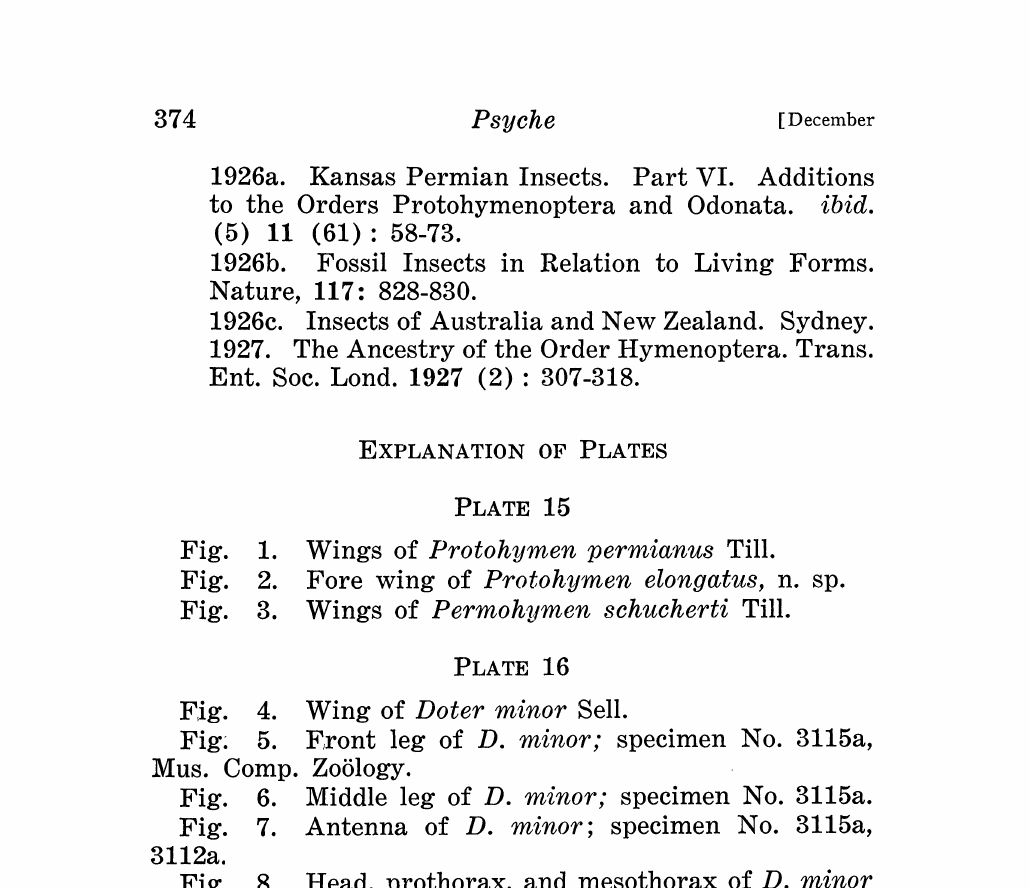
Fig. 1. Wings of Protohymen permianus Till. Fig. 2. Fore wing of Protohymen elongatus, n. sp. o Permohymen schucherti Till. Fig. 3. Wings PLATE 16 F.ig. 4. Wing of Doter minor Sell. Fig: 5. Front leg of D. minor; specimen No. 3115a, Mus. Comp. ZoSlogy. Fig. 6. Middle leg of D. minor; specimen No. 3115a. o D. minor; specimen No. 3115a, Fig. 7. Antenna 3112a. Fig. 8. Head, prothorax, and mesothorax of D. minor (lateral): No. 3115a. Fig. 9. Thorax of D. minor (dorsal) No. 3113a. of D. Fig. 10. Last five abdominal segments and cerci minor; No. 3115a. PLATE 17 Fig. 11. Photograph of obverse of Protohymen per- mianus Till., specimen No. 3060a, Mus. Comp. ZoSlogy. Fig. 12. Photograph of holotype of Asthenohymen kansasensis Till.; No. 5044a, Peabody Museum. Fig. 13. Photograph of wing of D. minor, specimen No. 3087a, Mus. Comp. ZoSlogy. Fig. 14. Photograph of part of cerci of D. minor, speci- men No. 3115a, Mus. Comp.